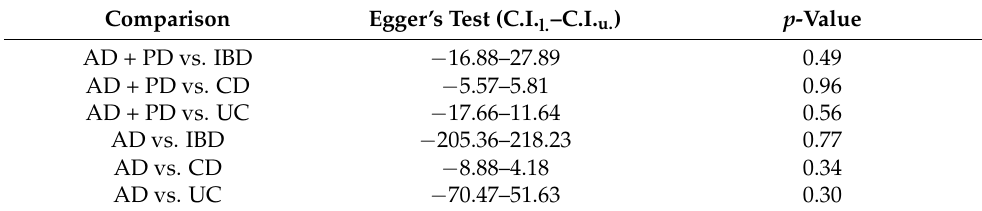
Table 2. Publication bias calculated with Egger’s test.